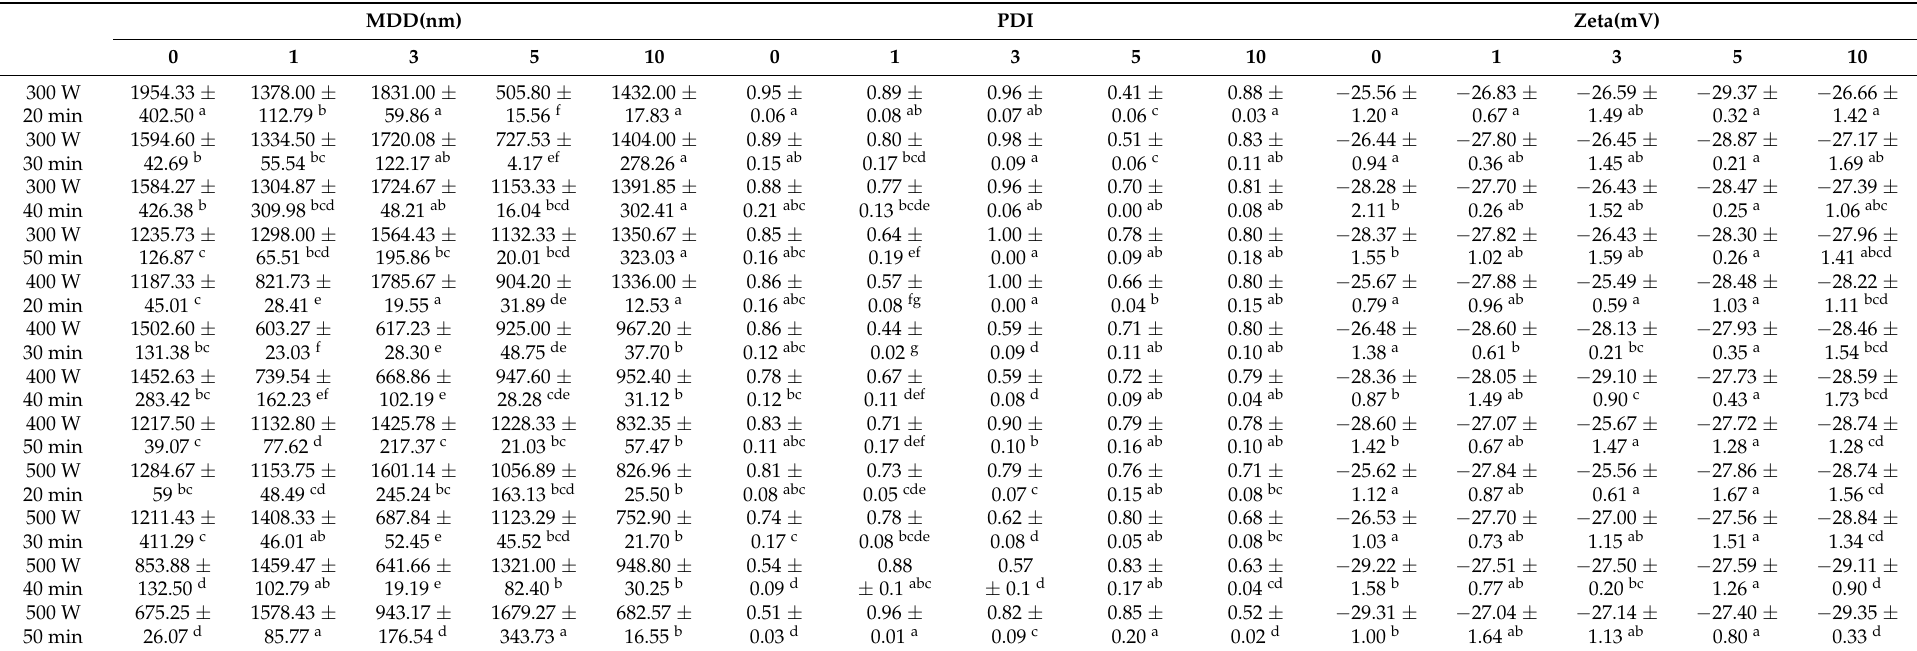
Table 1. Effect of ultrasonic intensity on MDD, PDI, and zeta potential of RBPE prepared by RB with different storage